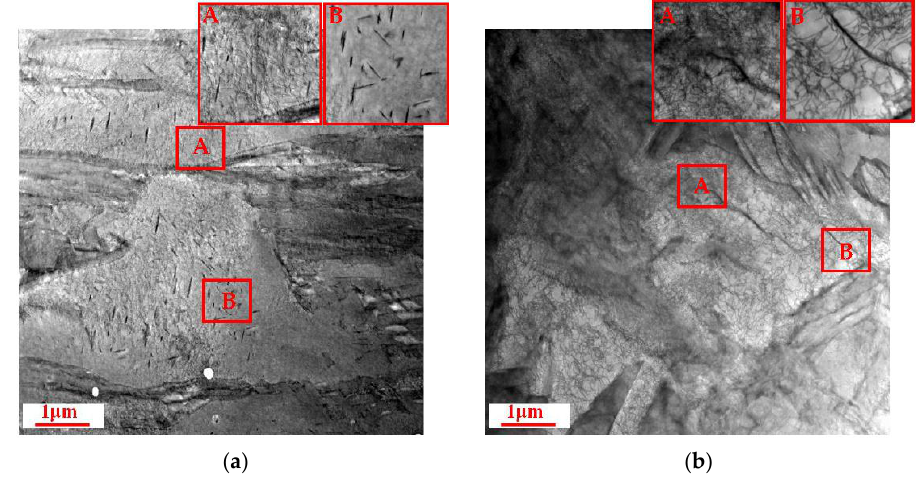
Figure 6. Dislocation distribution in the FZ of TWBs: ( a ) before and ( b ) after the magnetic treatment. In order to exhibit the distribution of dislocations, the enlarged images at local positions A and B are shown at the top right corner of each photograph. FZ: fusion zone; TWBs: laser tailor welded blanks. Figure 7a,b show the microstructures in the HAZ of the non-magnetically and magnetically treated TWBs, respectively. It can be seen that, similar to that of the weld zone, after the magnetic treatment, the dislocation density in the HAZ increased obviously and dislocation nets were formed in some local areas.